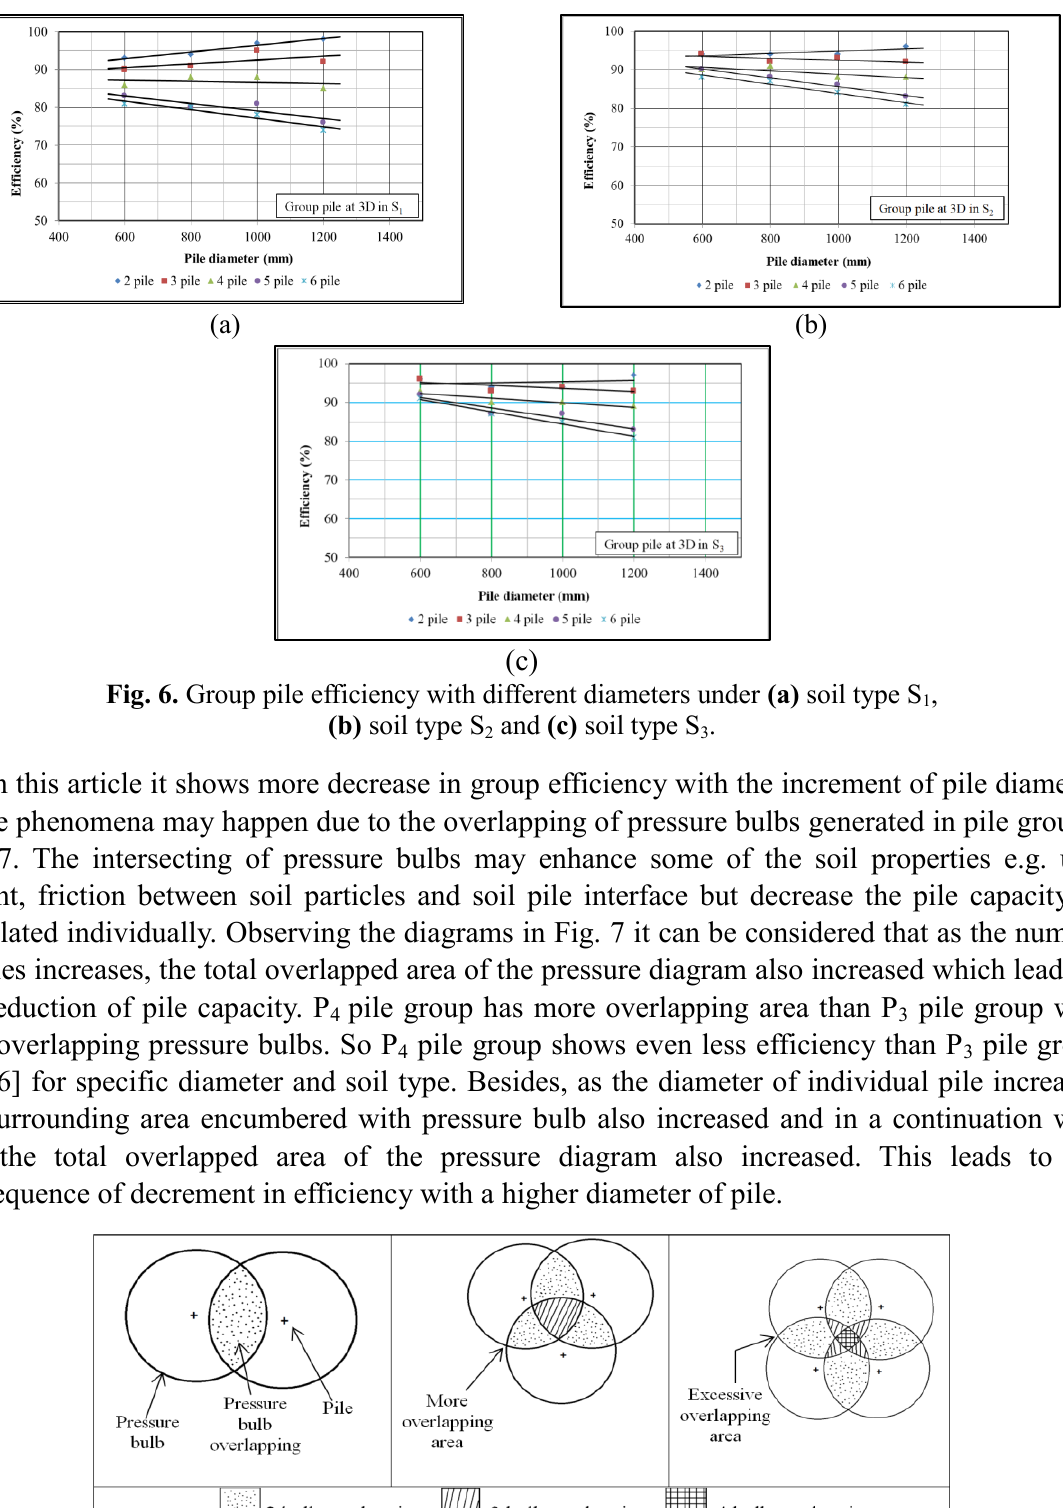
piles (b) P piles (c) P 2 3 4